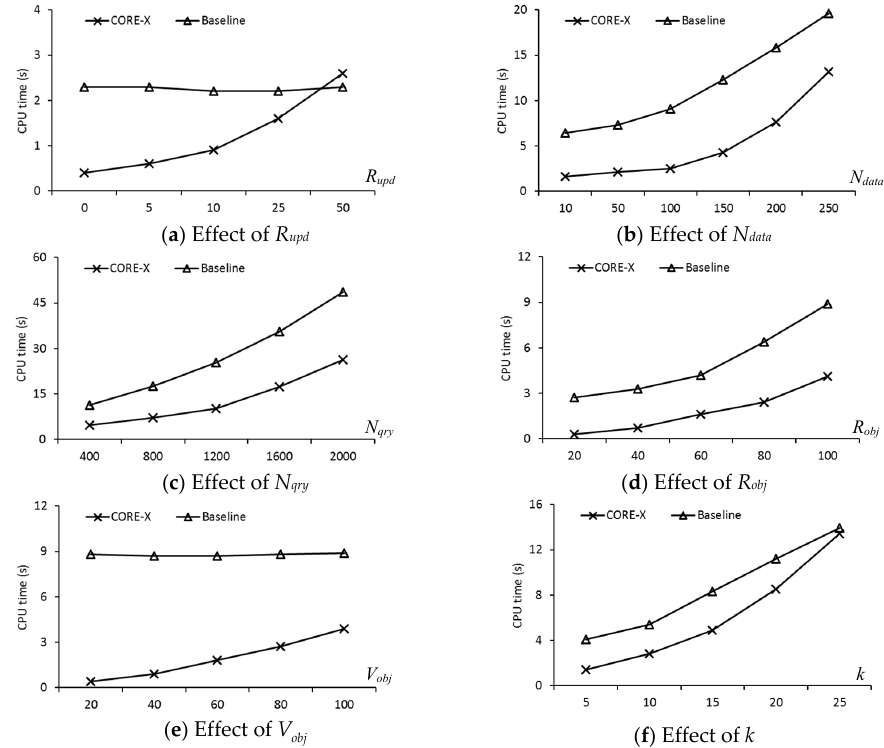
Figure 16. Comparison of the computational cost. ( a ) Effect of R upd ; ( b ) Effect of N data ; ( c ) Effect of N qry ; ( d ) Effect of R obj ; ( e ) Effect of V obj ; ( f ) Effect of k.